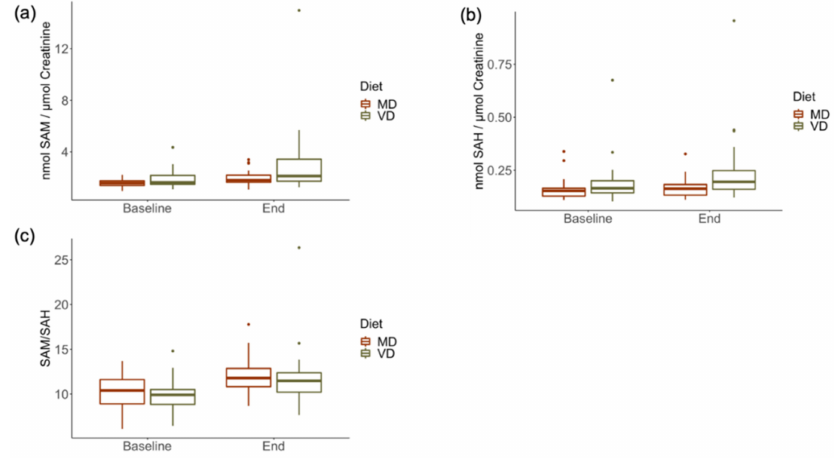
Figure 7. Urinary concentration of SAM, SAH, and the SAM:SAH ratio (SAM/SAH) in an RCT with a 4 week intervention with vegan (VD) and meat-rich (MD) diets. ( a ) Urinary SAM at baseline and the end of the trial. ( b ) Urinary SAH at baseline and the end of the trial. ( c ) Ratio of urinary SAM and SAH at baseline and the end of the trial. The concentrations of SAM and SAH were normalised by the concentration of creatinine to account for varying hydration at the time of sample collection and renal function. Box plots show the median values (lines within the boxes) and the whiskers represent 1.5 interquartile ranges. Values that are classified as outliers are also shown.